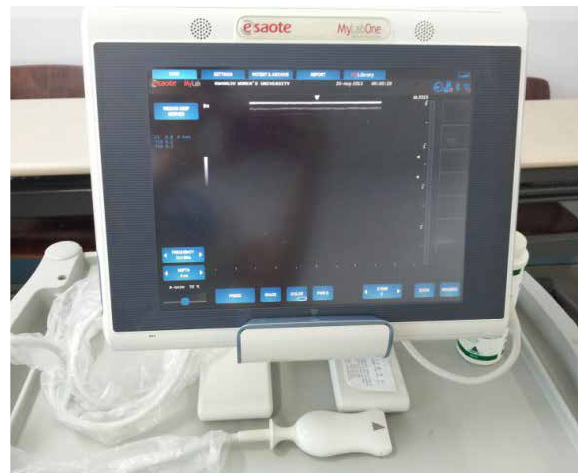
Figure 2: Device of real-time ultrasonography